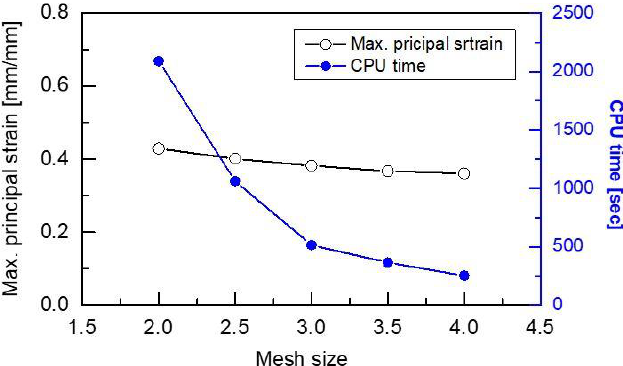
Figure 9. MPS and CPU time vs. mesh size.